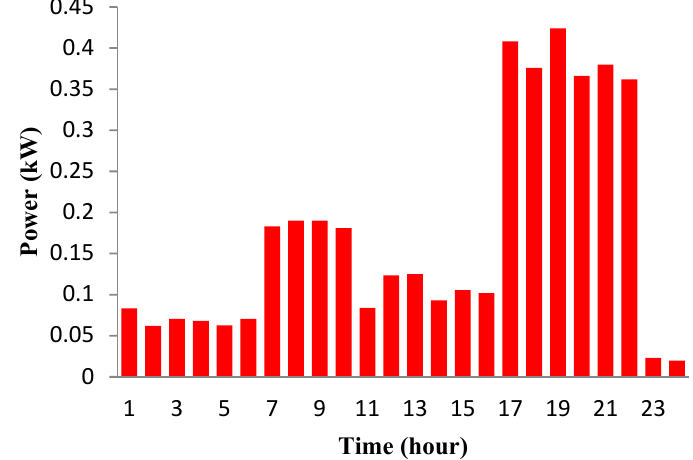
Energies 2020 , 13 , x FOR PEER REVIEW Figure 5. Predicted load profile of a house during peak hours over a 24 h horizon.